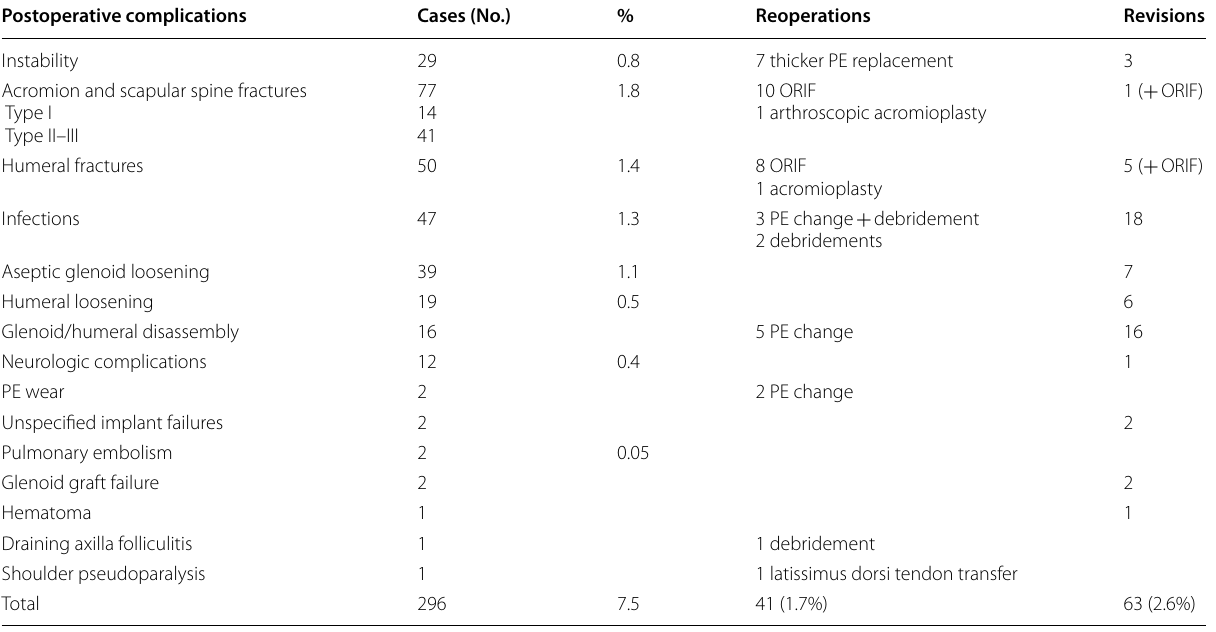
PE polyethylene insert, ORIF open reduction internal